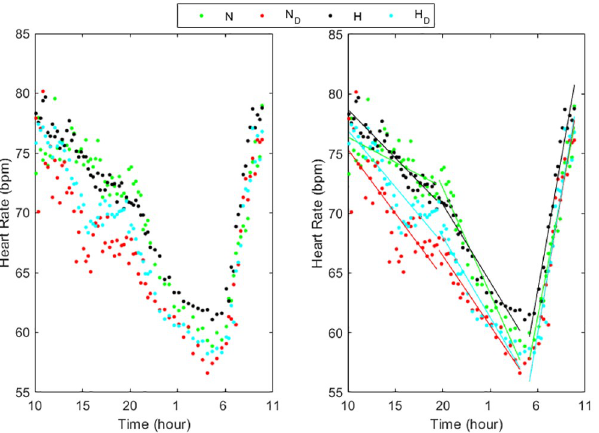
Fig 2. Circadian rhythms of HR in normotensive and hypertensive subjects with and without dyslipidemia (left panel) and their linear regression (right panel) in the three periods considered (10:00–20:00, 20:00–4:00, 5:00– 10:00). N = Normotensive, N D = Normotensive with dyslipidemia, H = Hypertensive, H D = Hypertensive with